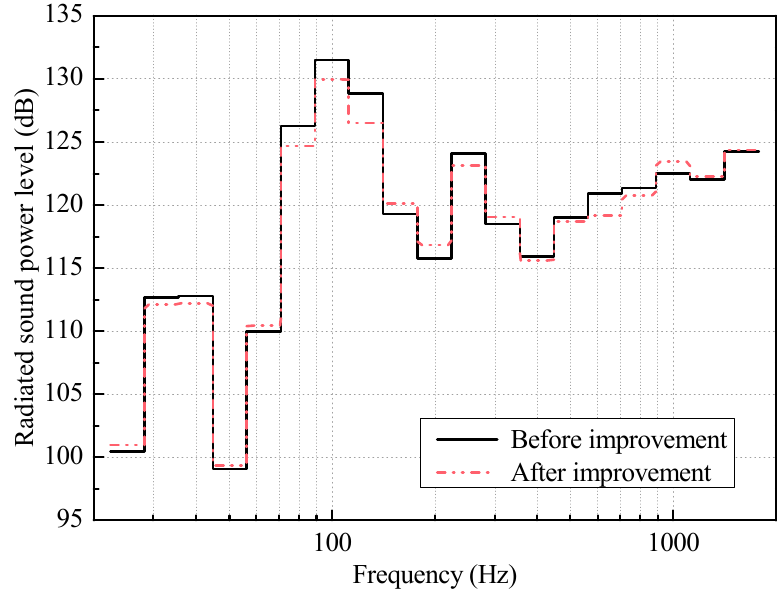
Figure 14. Diesel engine radiated sound power level before and after improvement.